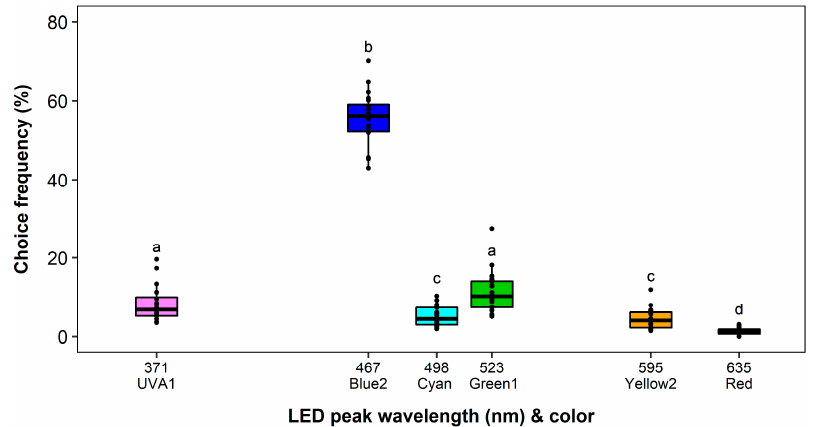
Figure 3. Wavelength preferences of Frankliniella occidentalis in multiple-choice experiment with light- emitting diodes (LEDs) in the complete spectral range of ultraviolet and visible light. See Table 1 and Figure 2 for LED color specifications. Significant differences are indicated by different letters (generalized linear model, Tukey test, p < 0.05, n = 20).